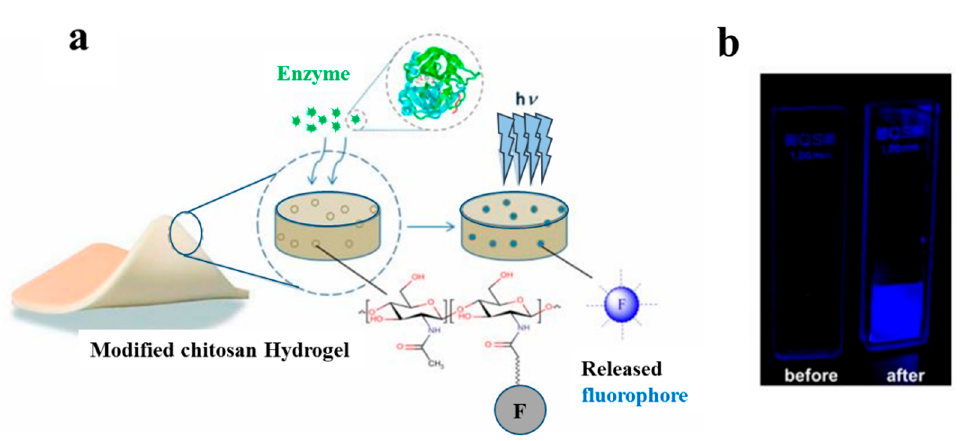
Figure 7. ( a ) Schematic of the interaction between modified chitosan hydrogel and an enzyme; ( b ) images of modified hydrogel before and after enzymatic degradation [118] .